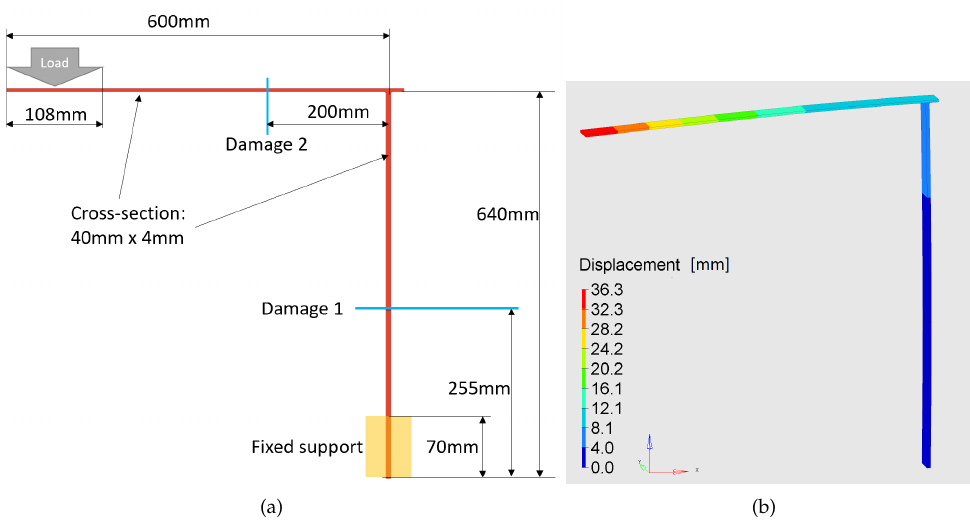
Figure 12. The L-shape crane structure under investigation: ( a ) scheme with dimensions, and ( b ) dis- placements computed by the FEA.